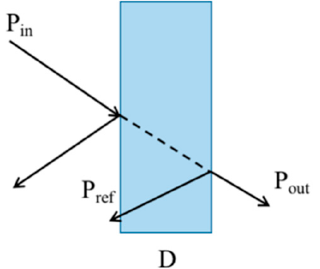
Figure 3. Schematic diagram of D-band millimeter-wave signal transmission.